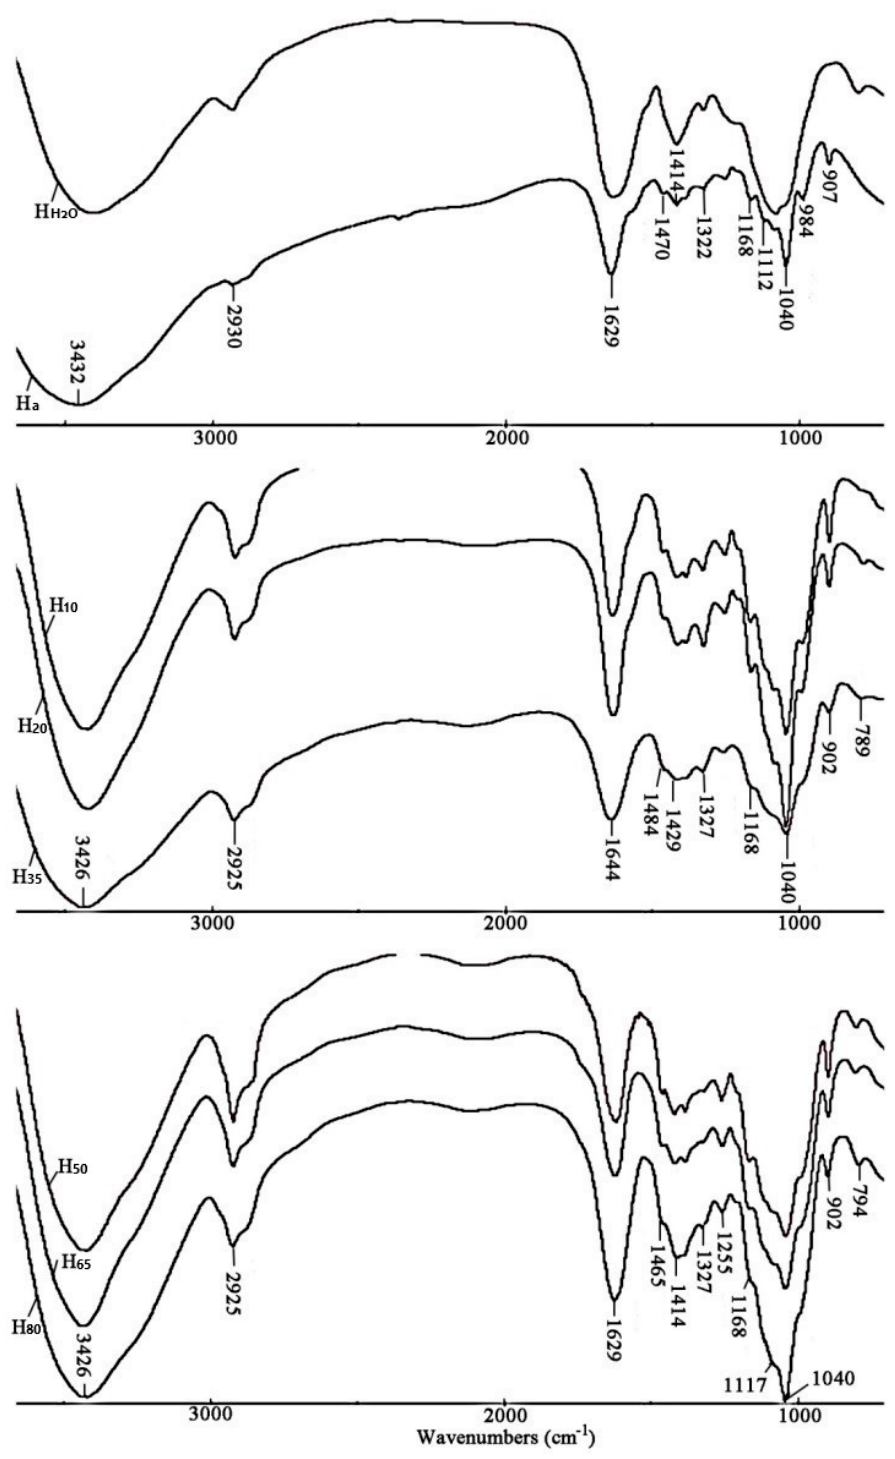
Figure 2. FT-IR spectra of the hemicellulosic fractions.